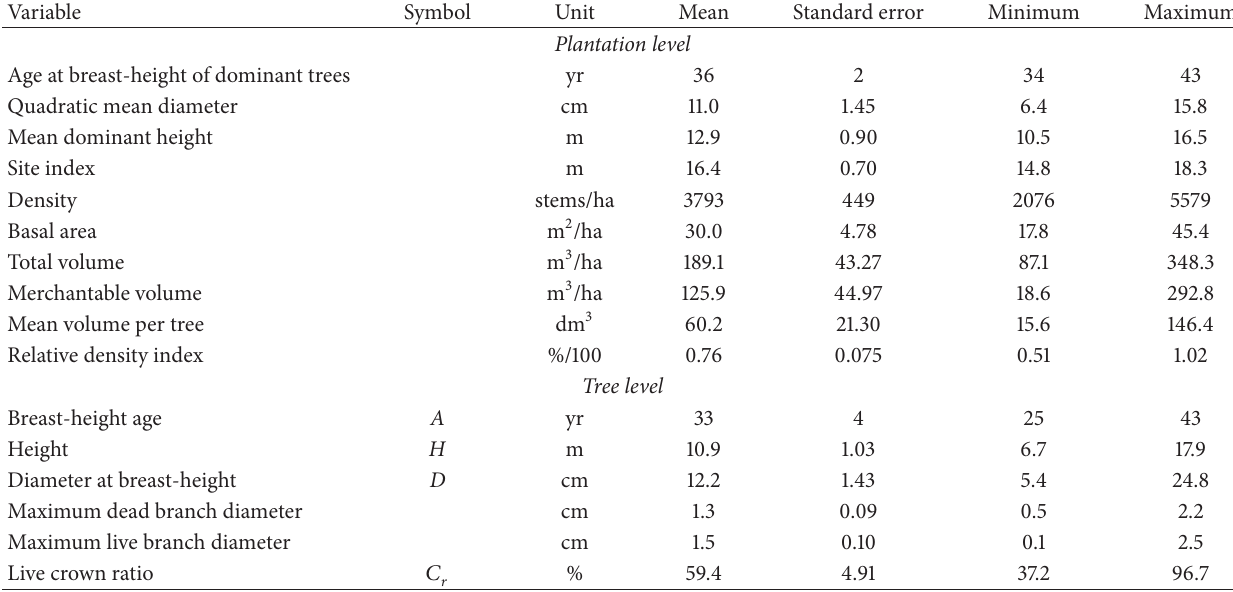
Table 2: Descriptive statistical summary of the mensurational characteristics of the 5 plantations and 47 sample